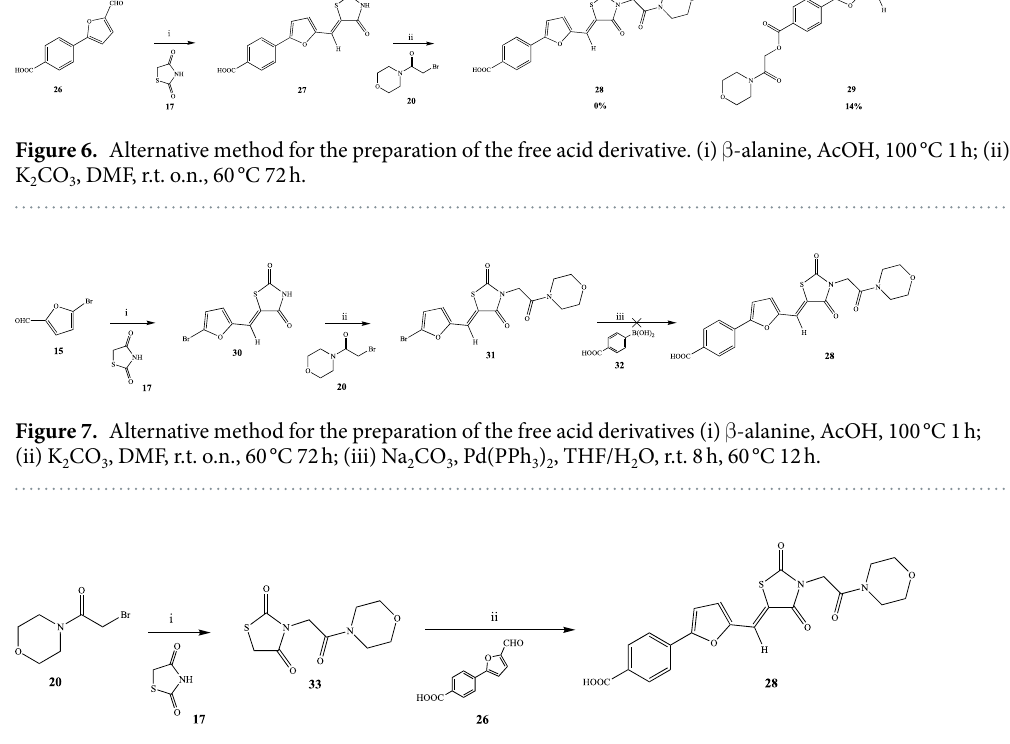
Figure 8. Preparation of the free acid derivative 28 (i) K 2 CO 3 , DMF, r.t. o.n., 60 °C 72 h; (ii) β -alanine, AcOH, 100 °C 1